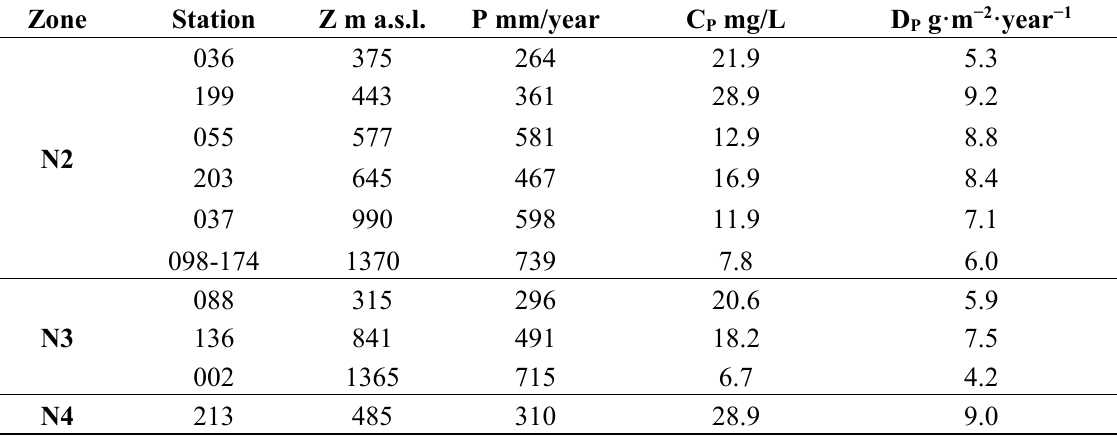
Figure 3. Modified Stiff diagrams of the representative rainwater chemistry of each rainfall station, weighted by the amount of rainfall in each collector. Runoff chemistry is also represented (average values when more than one sample was available at the same sampling point). Average isohyets (mm/year) for the 1970–2011 period are also shown. Table 2. Results of atmospheric chloride bulk deposition in the area. Z = elevation; P = precipitation; C P = precipitation-weighted average chloride concentration in rainfall during the study period; D P = average atmospheric chloride deposition during the study